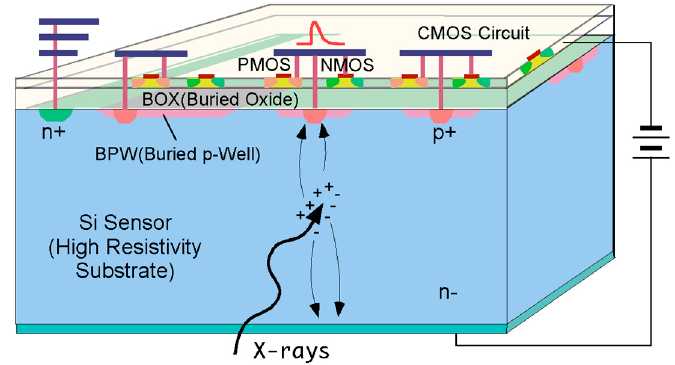
Figure 1. The cross-sectional view of the SOIPIX.